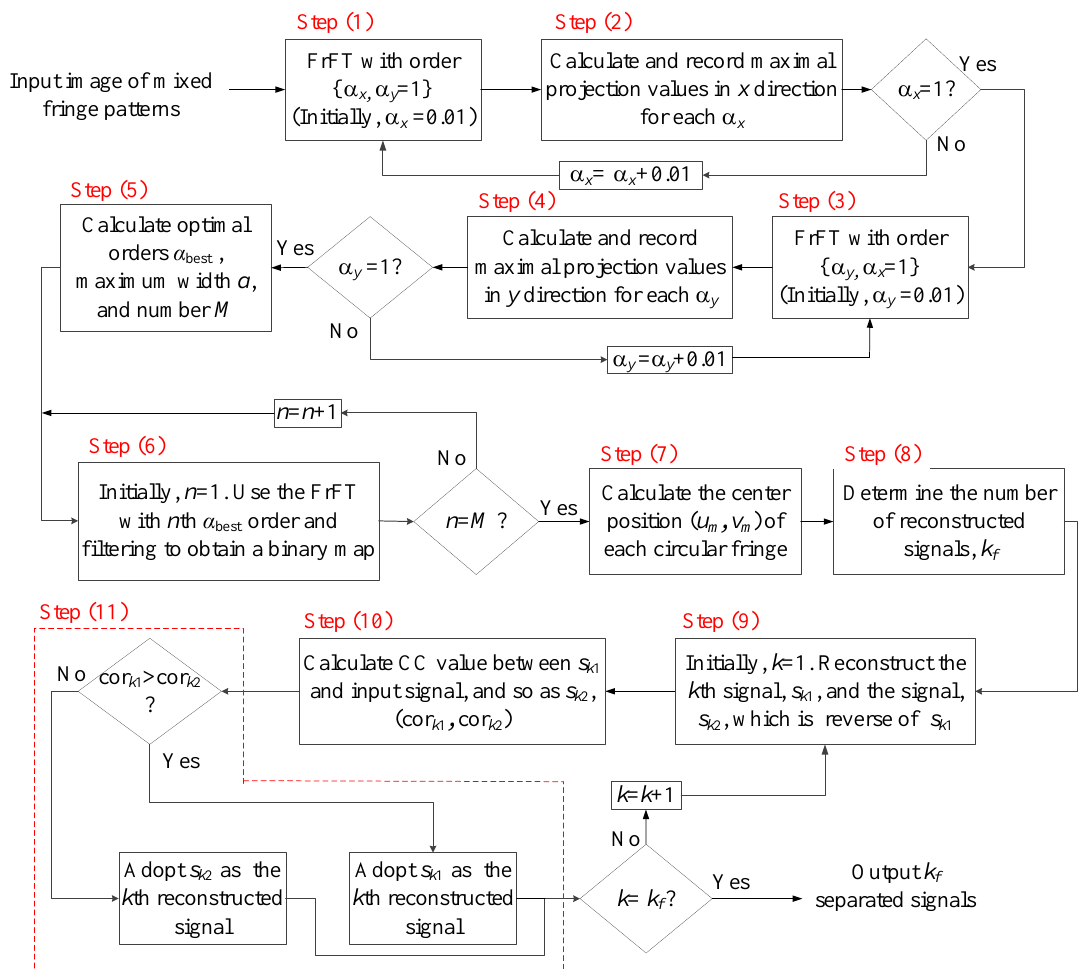
Figure 2. The systematic block diagram of the proposed method.